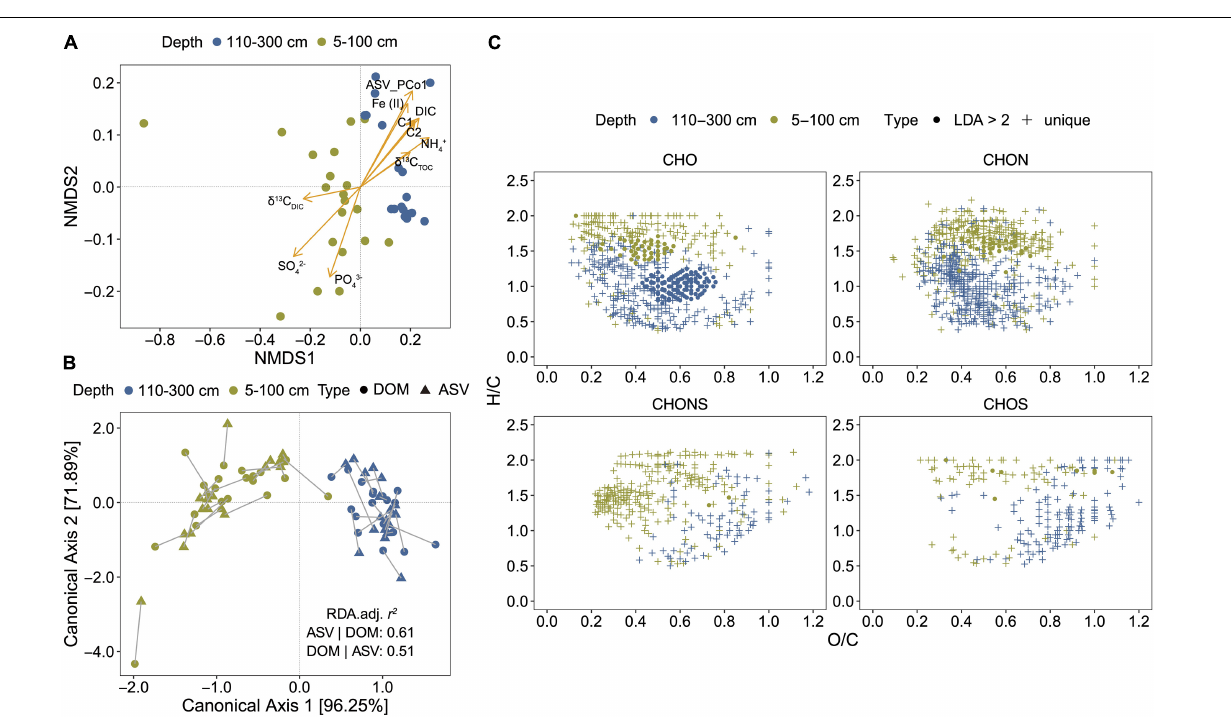
PCo1 of microbial Bray-Curtis distances (ASV_PCo1) ( r > 0.7, P < 0.01) may have significantly shaped the DOM composition ( Figure 2A ). dbRDA were conducted to estimate the contribution